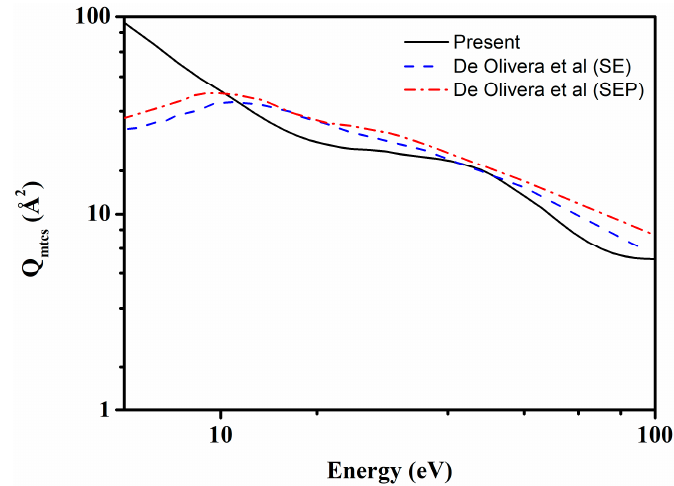
Figure 11. Momentum transfer cross-section for butanol isomers: present results are depicted as lines and results from Bettega et al. are shown as lines with open circles. Butan-2-ol results are shown in black, 2-methylpropan-1-ol in red and 2-methypropan-2-ol results in blue colour.